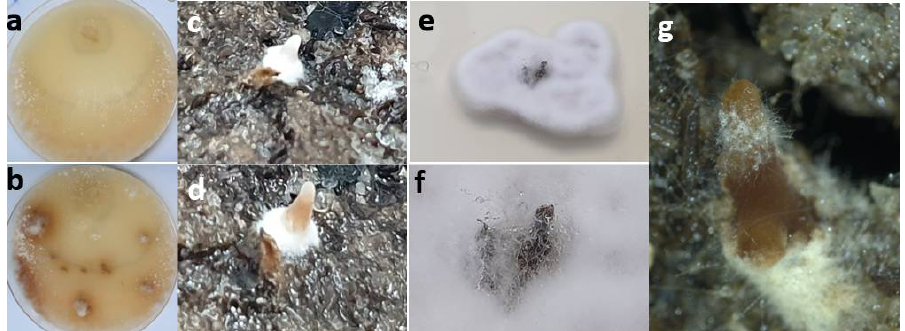
Figure 3. Pathogenicity assays of P. lilacinum 1925-1 against M. rufobrunnea . ( a,b ) M. rufobrunnea mycelial culture after inoculation of P. lilacinum spores on day 3 of growth ( a ) and 72 h later ( b ); ( c,d ) Young primordia in the growing system before (white, 3–8 mm long) ( c ) and 48 h after ( d ) inoculation with P. lilacinum spores; ( e ) Infected primordia with established P. lilacinum colony after transfer from the growing system to PDA medium; ( f ) Infected primordia covered by P. lilacinum hyphae on PDA; ( g ) Infected primordia on cultivation soil.